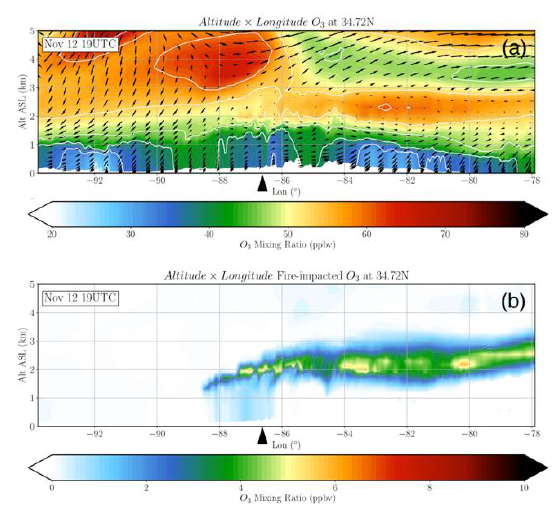
Figure 2. (a) Modeled longitude-altitude curtain of O 3 mixing ratio (ppbv) across 34.72  N on 1900UTC Nov 12-14, 2016 at 0-5km ASL altitude. Arrows indicate modeled horizontal wind direction. A black triangle marks the location of Huntsville. (b) Same as Figure 2a, but for fire-impacted O 3 mixing ratio. Note the colorbar range is different from Figure